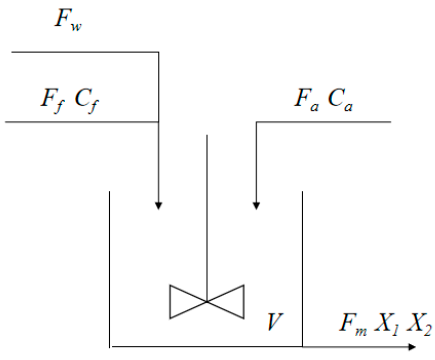
Figure 2. The dynamic process of acid-base neutralization.